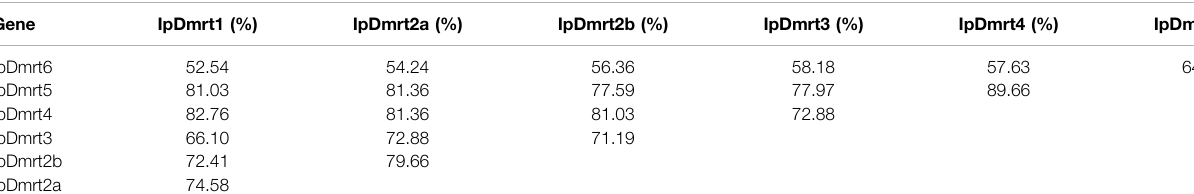
TABLE 2 | Identity of the amino acid sequences of IpDmrt genes.